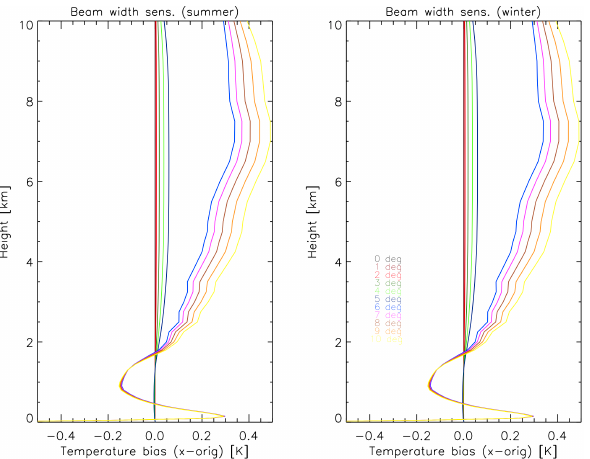
Fig. 15. The error in the retrieved temperature caused by the errors in TB by not taking into account antenna beam width for different levels in the atmosphere. The errors are shown for both the mid-latitude summer (right) and the mid-latitude winter (left) soundings for different beam widths (colour scale).